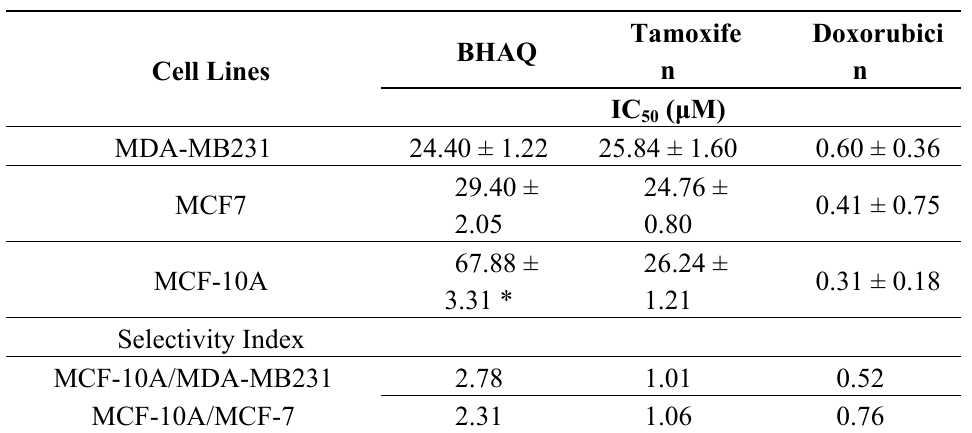
Table 1. The IC values of BHAQ, tamoxifen and doxorubicin in MDA-MB231, MCF-7 50 and MCF10A cell lines at 48 h post-treatment. The selectivity index of each drug was also in non-cancerous MCF-10A cell line/IC measured, IC 50 are expressed as mean ± SD. * p < 0.05 compared with corresponding